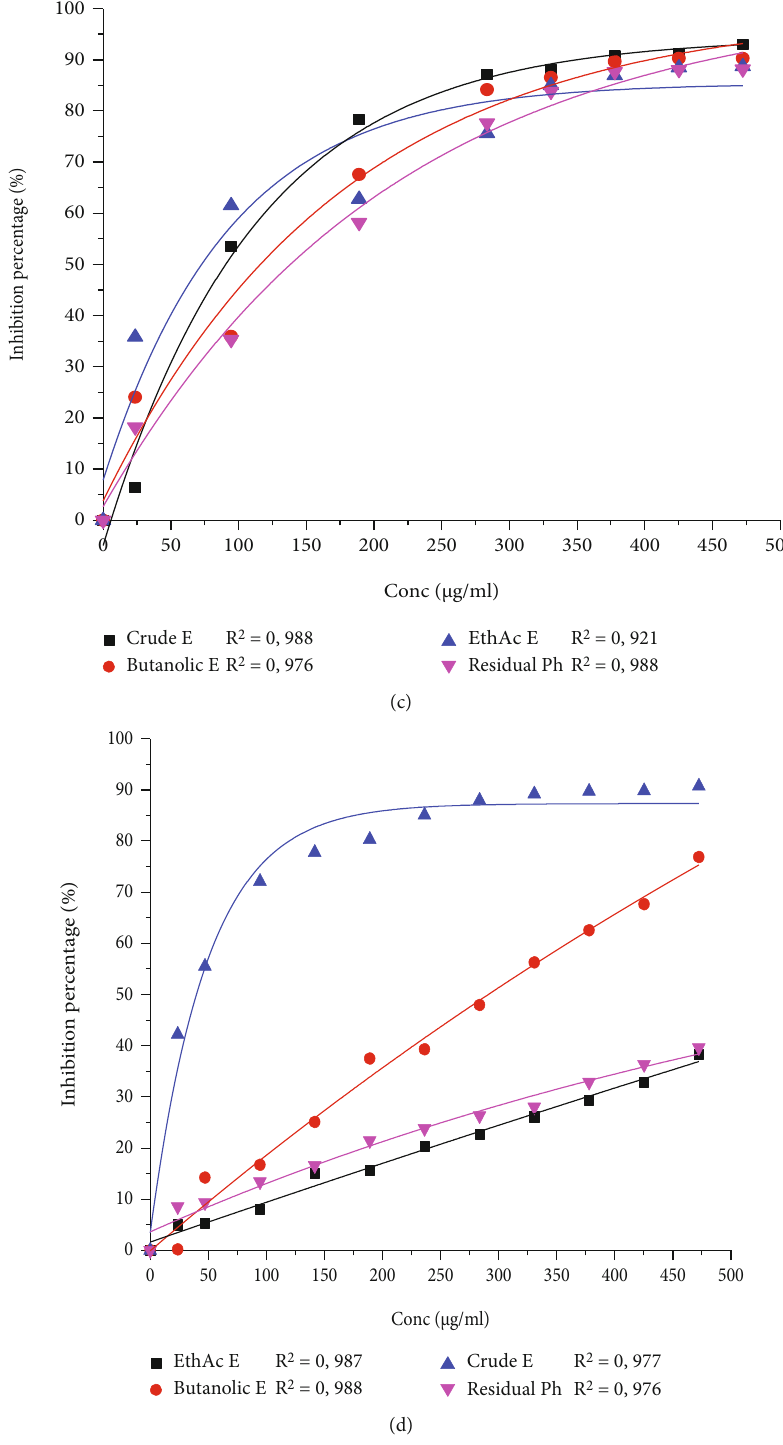
Figure 5: Inhibition Percentage of Pistacia atlantica extracts: reference standards (a), leaves (b), fruits (c), and bark